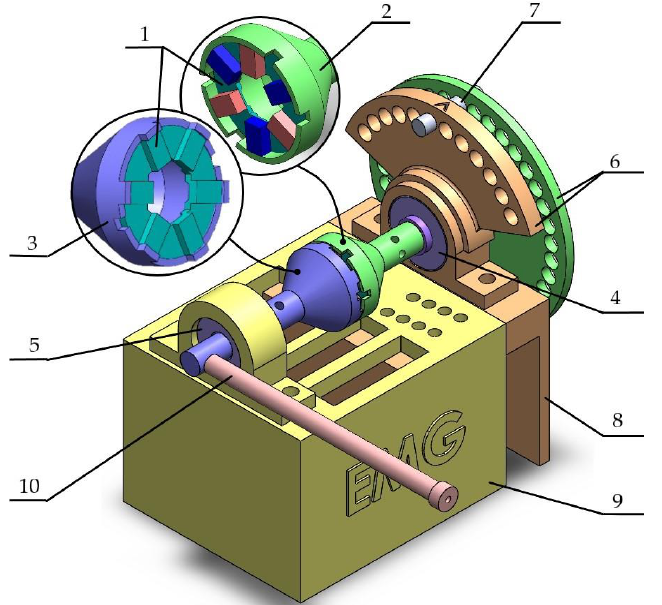
Figure 12. First view of the experimental setup. 1—PM coupling; 2—driving member shaft; 3— driven member shaft; 4 and 5—bearings; 6—mechanism for the angle θ variation; 7—stick for fixing the angle θ ; 8 and 9—bed components; 10—arm.